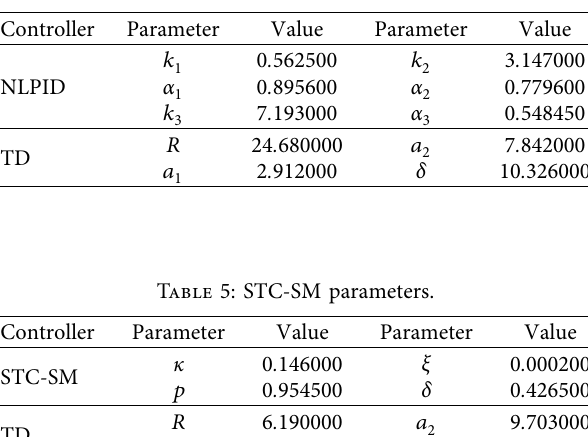
Table 4: NLPID parameters.